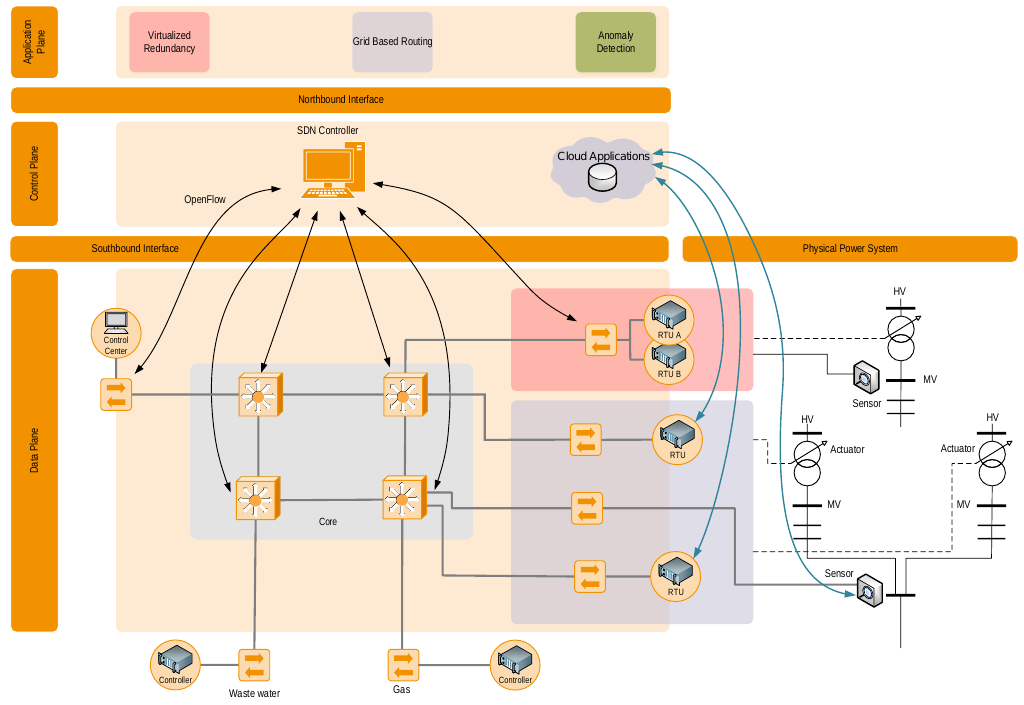
Figure 1. System model for communication virtualisation in power system control